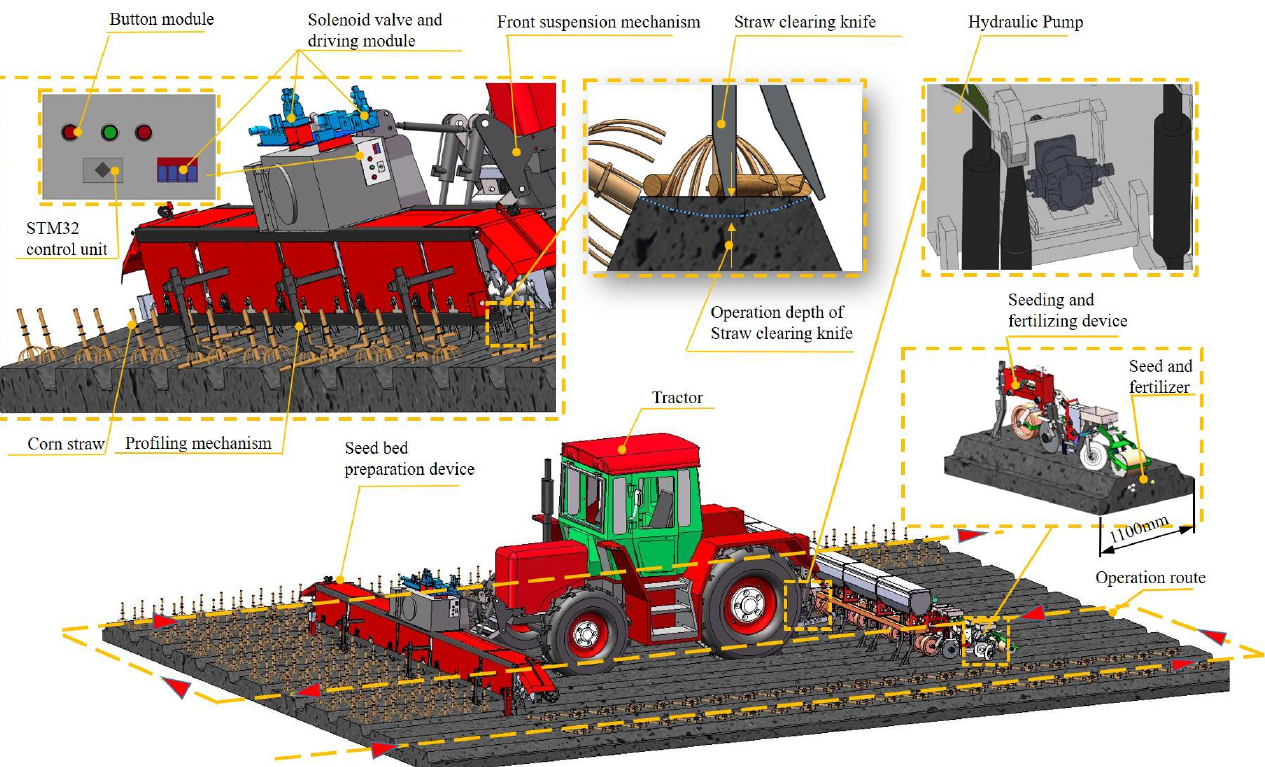
Figure 1. Overall structure of the straw-clearing-depth self-adaptive control system of a front- mounted seedbed-preparation device.